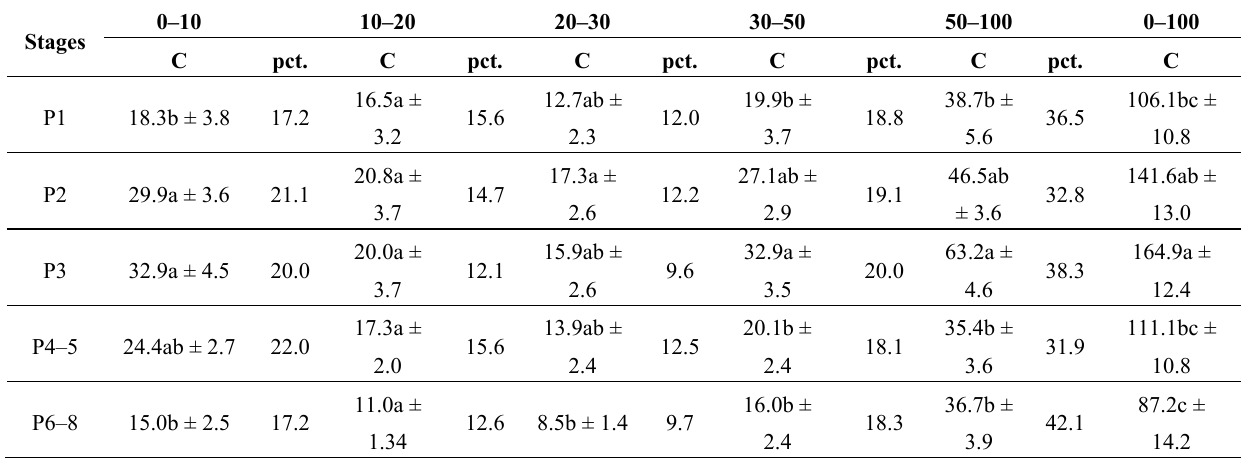
Figure 3. General pattern of C concentration in soil of the Eucalyptus plantation. Table 4. C storage (Mg ha − 1 ) of mineral soil in the Eucalyptus